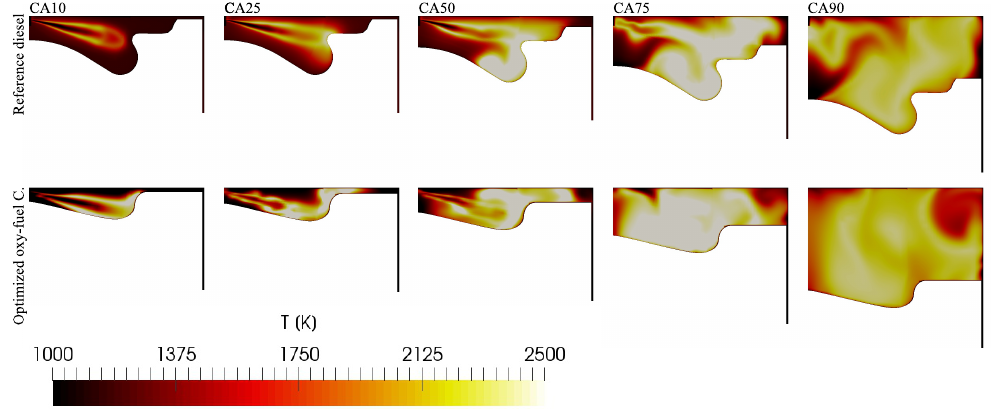
Figure 17. Temperature distribution inside the combustion chamber for a several combustion periods (CA) comparison between the reference diesel and optimized oxy-fuel combustion